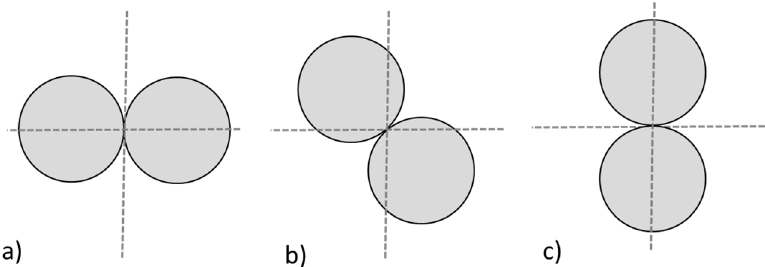
Figure 6. The moment of inertia of the twisted wires change according to their relative position: considering the horizontal axis, the minimum value is obtained in ( a ), while the maximum one in ( c ). The configuration shown in ( b ) returns the average value.